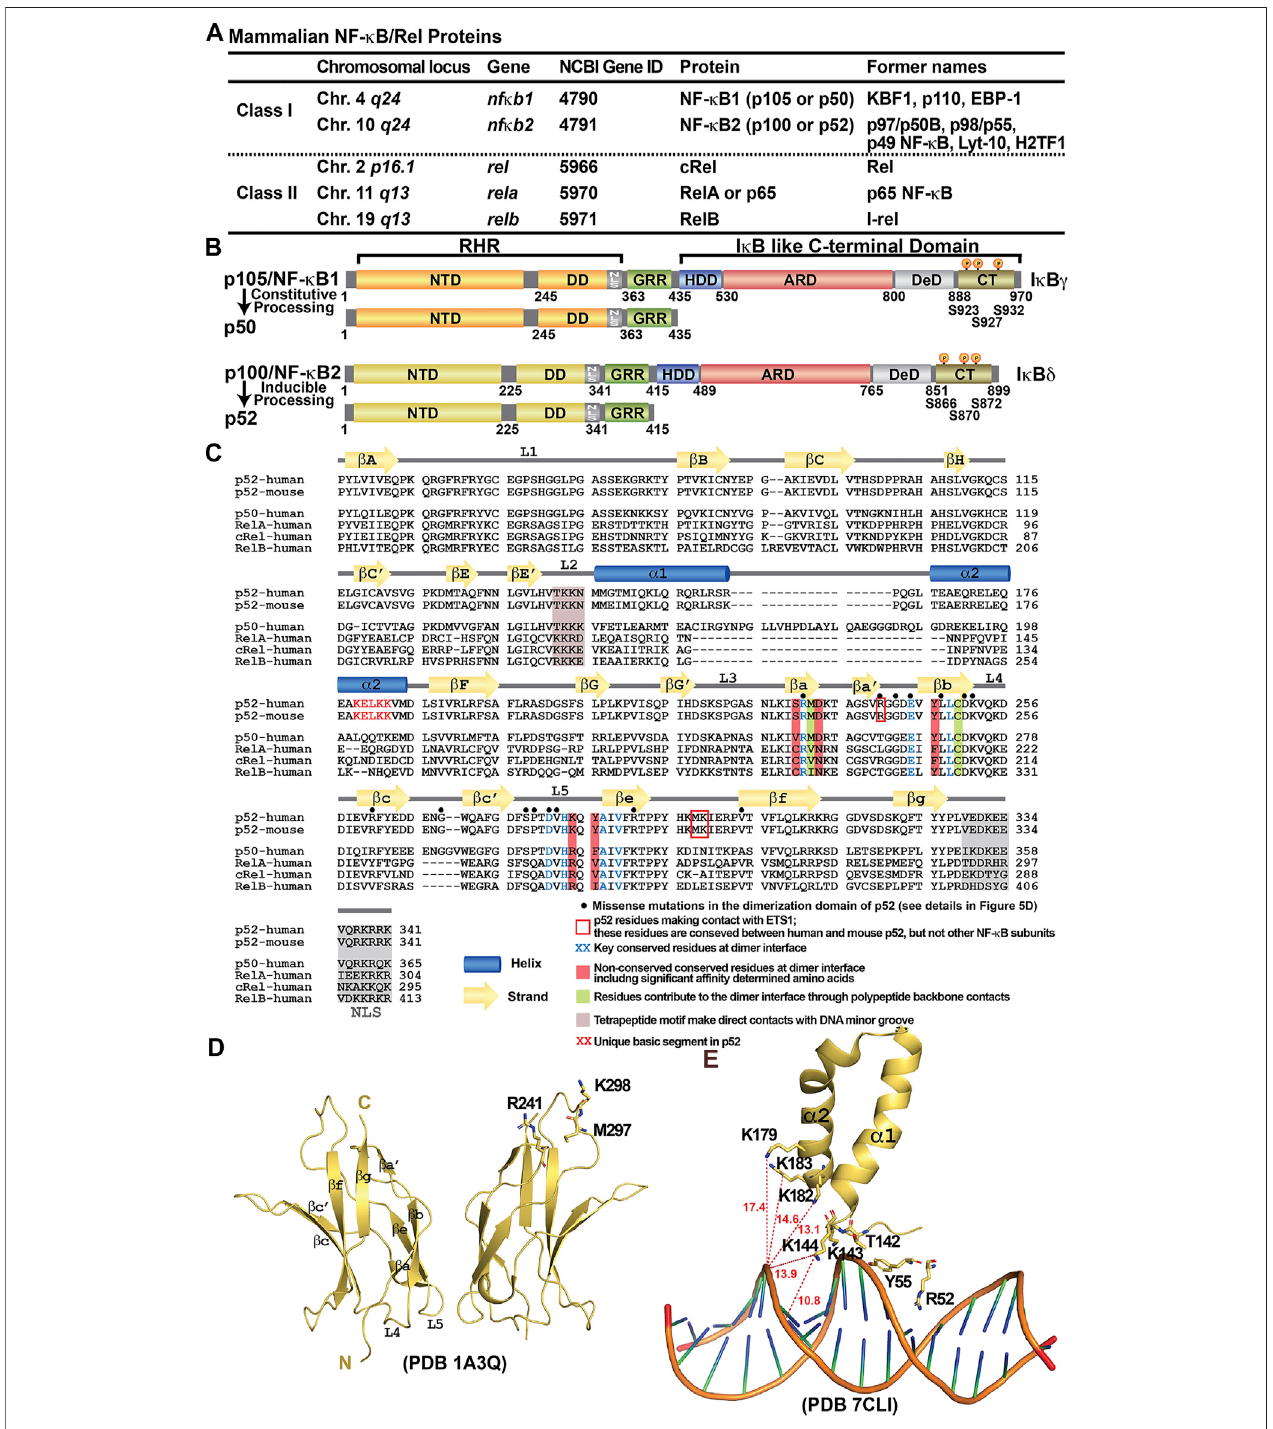
FIGURE 1 | Discovery of NF- κ B and NF- κ B dimers. (A) Table summarizing the mammalian NF- κ B proteins. The chromosomal locus on the human genome, the gene name and theGene IDat NCBI ofthe fi vefamily membersare listed.Due tothe complexity ofthefamily at both genetic and biochemical levels, these proteins have beennamedwithvariousnomenclaturethroughouttheirdiscoveries;theirformernamesintheliteraturewerealsoindicatedinthetable. (B) Domainorganizationofclass I NF- κ B: NF- κ B1 (p105/p50) and NF- κ B2 (p100/p52). (C) Sequence alignment of the RHR of NF- κ B subunits. Both human and mouse sequences of the p52 subunit are shown. Only human sequences are shown for the rest of the family members. Secondary structures and connecting loops are drawn above the sequences. The NLS is highlighted in grey. Black circles on top of the sequences indicates the missense mutations in the dimerization domain of p52, detail information is listed in Figure 5D . (D) Ribbon diagram of the p52 DD homodimer indicating the secondary structure elements and overall immunoglobulin (Ig)-like fold. Three residues interacting with ETS1 are indicated; they are located away from the dimer interface. These residues are conserved between mouse and human p52, but not present in other NF- κ B subunits. (E) A unique basic segment in p52 NTD helix α 2 interacts with target DNA.